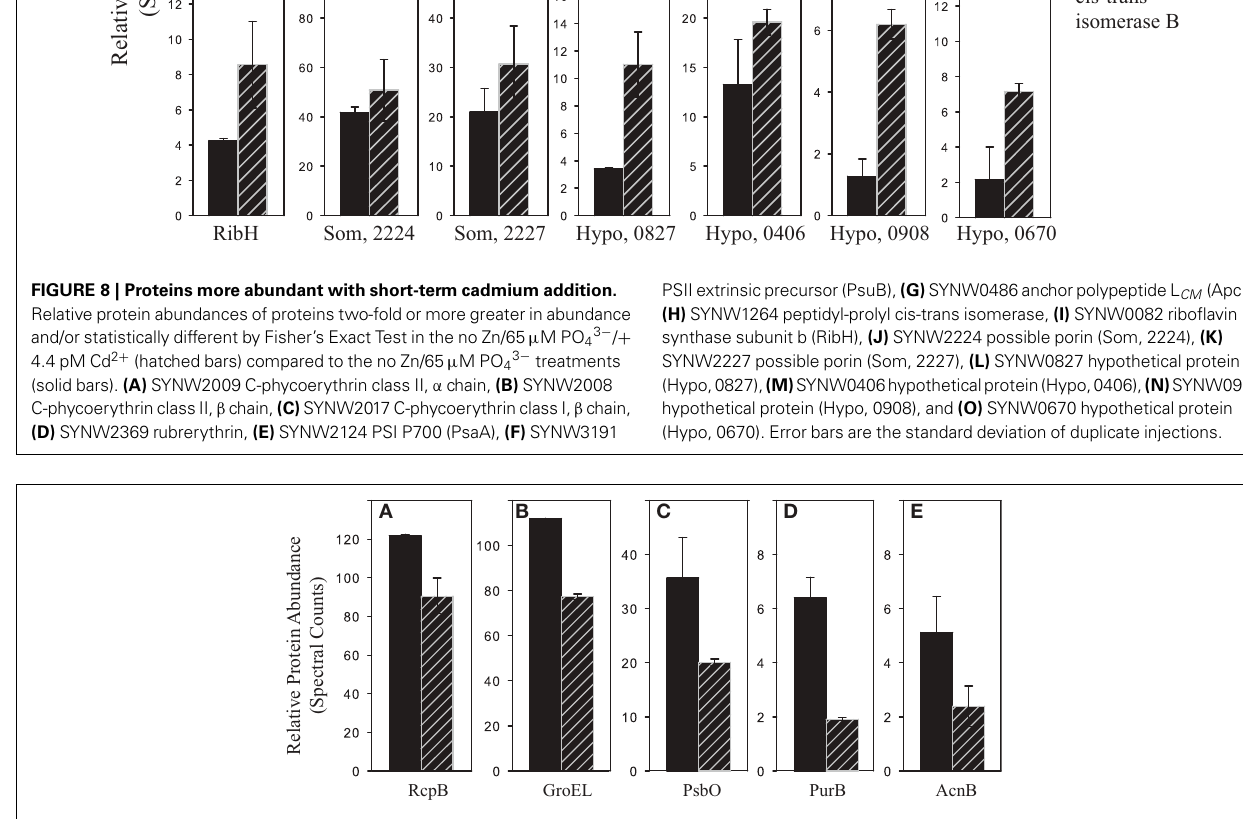
R-phycocyanin II, β chain (RpcB), (B) SYNW0514 chaperonin GroEL (GroEL), (C) SYNW0303 PSII Mn-stabilizing polypeptide (PsbO), (D) SYNW0405 fumarate lyase: adenylosuccinate lyase (PurB), and (E) SYNW2500 aconitate hydratase (AcnB). Error bars are the standard deviation of duplicate